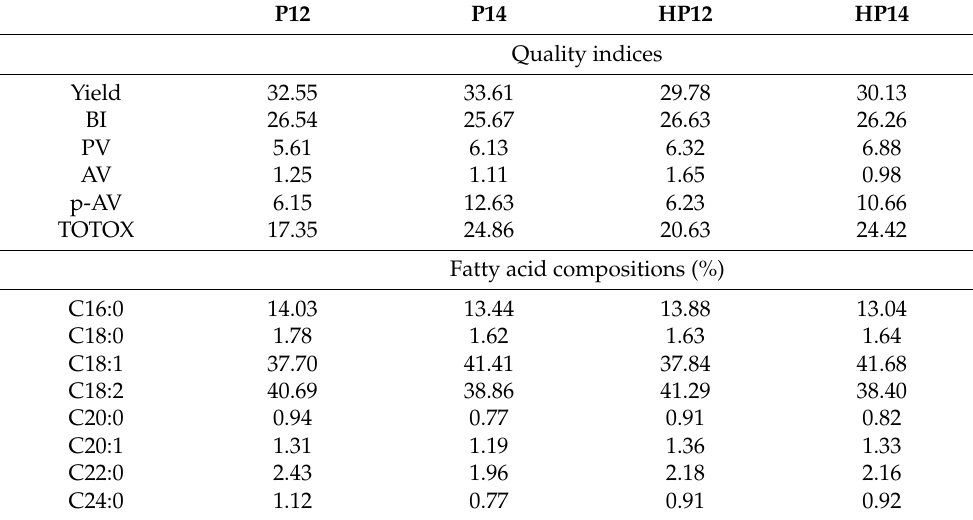
Table 1. Quality index and fatty acid composition (%) for P12, P14, HP12, and